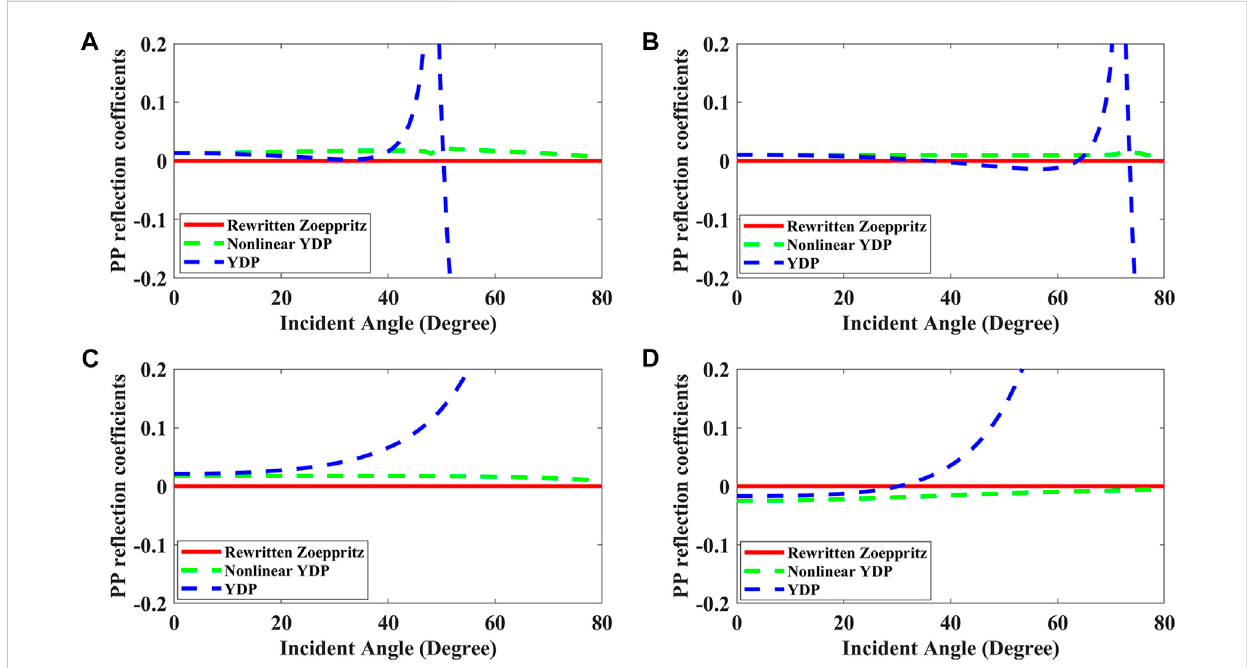
FIGURE 2 Error analysis of the P-to-P wave re fl ection coef fi cients calculated by the newly rewritten Zoeppritz equation (red curves), the YPD approximation (blue dotted curves), and the non-linear YPD equation (green dotted curves) for four models [ (A) I (B) II (C) III (D) IV].